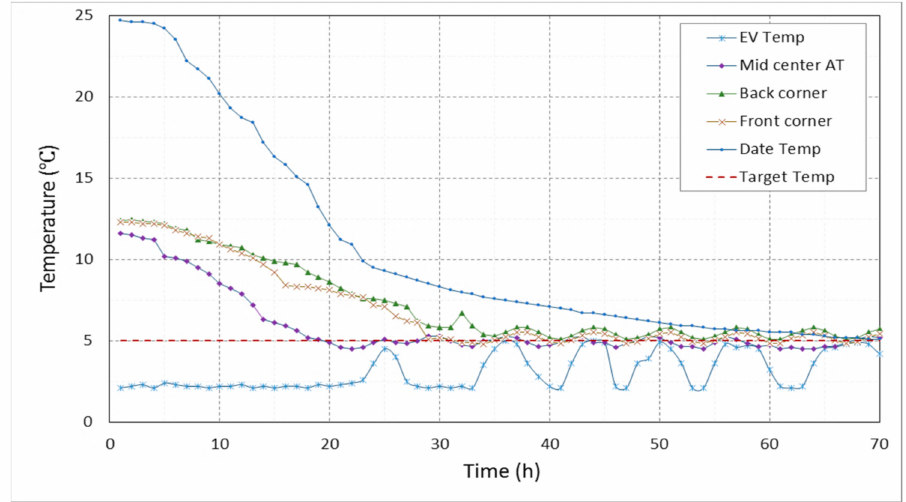
Figure 9. Temperature distribution in the controlled cold storage room for the evaporator (EV Temp), at the centerline of the cold room (Mid Center AT), at the corners behind the evaporator (Back corner), at the front corners (Front corner), and in the middle of date crats (Date Temp) at the target temperature (Target Tem) and 80% relative